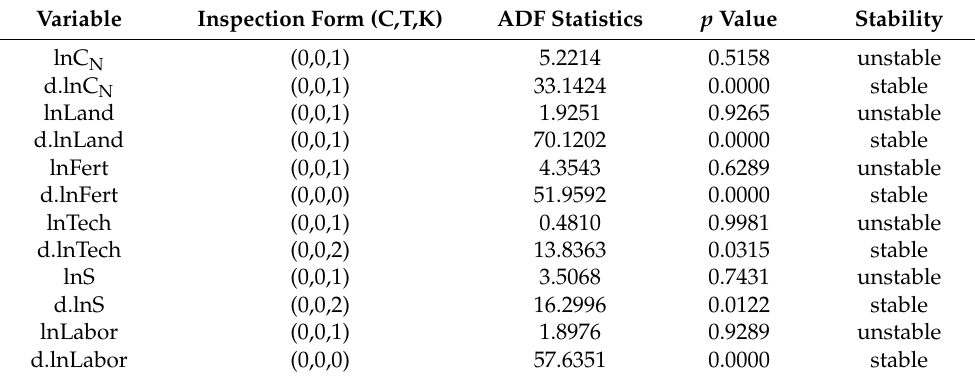
Table 6. ADF Unit root test.